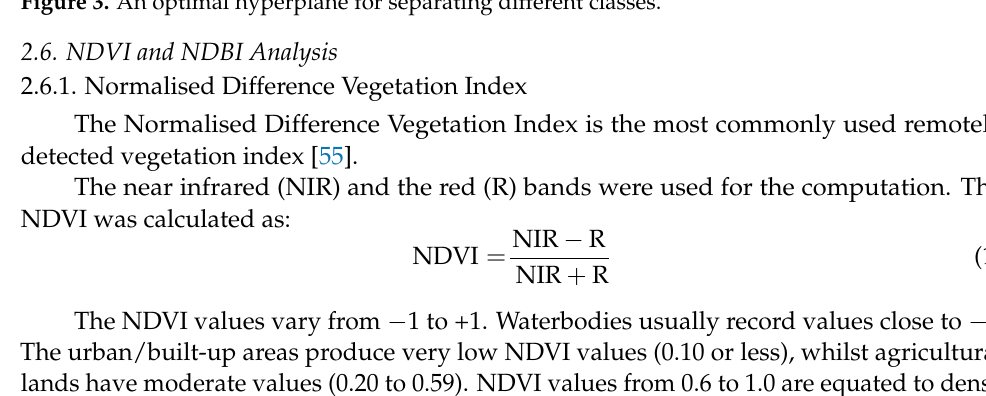
Figure 3. An optimal hyperplane for separating different classes.